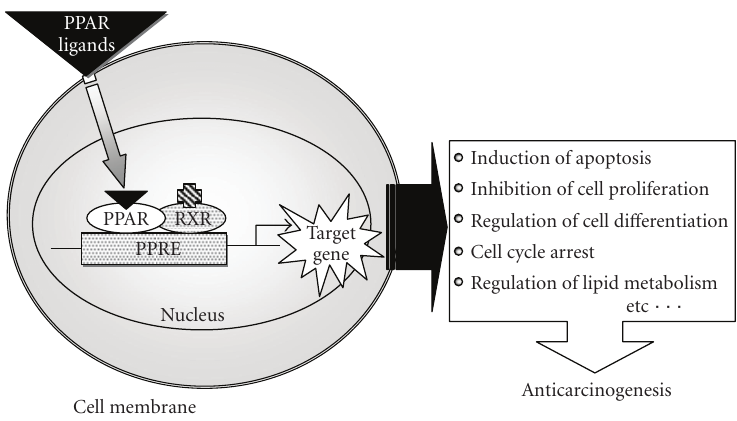
Figure 1: PPAR activation pathway and its target